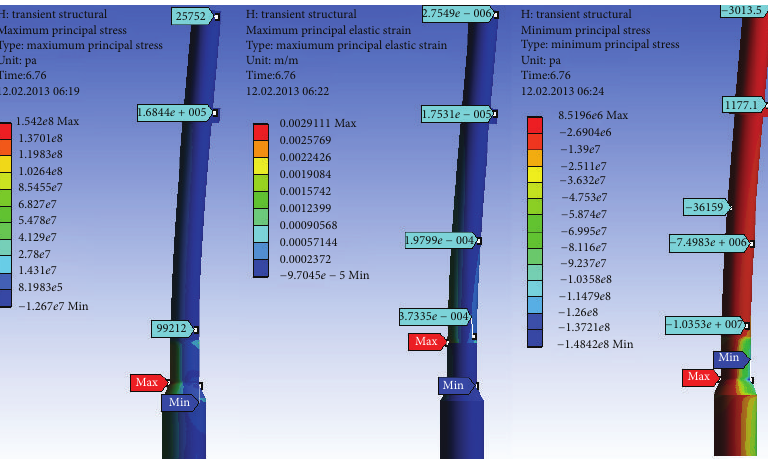
Figure 16: Maximum principal stress, maximum principal stain and minimum principal stress distribution for strengthened minaret under the effect of scaled Duzce record (in